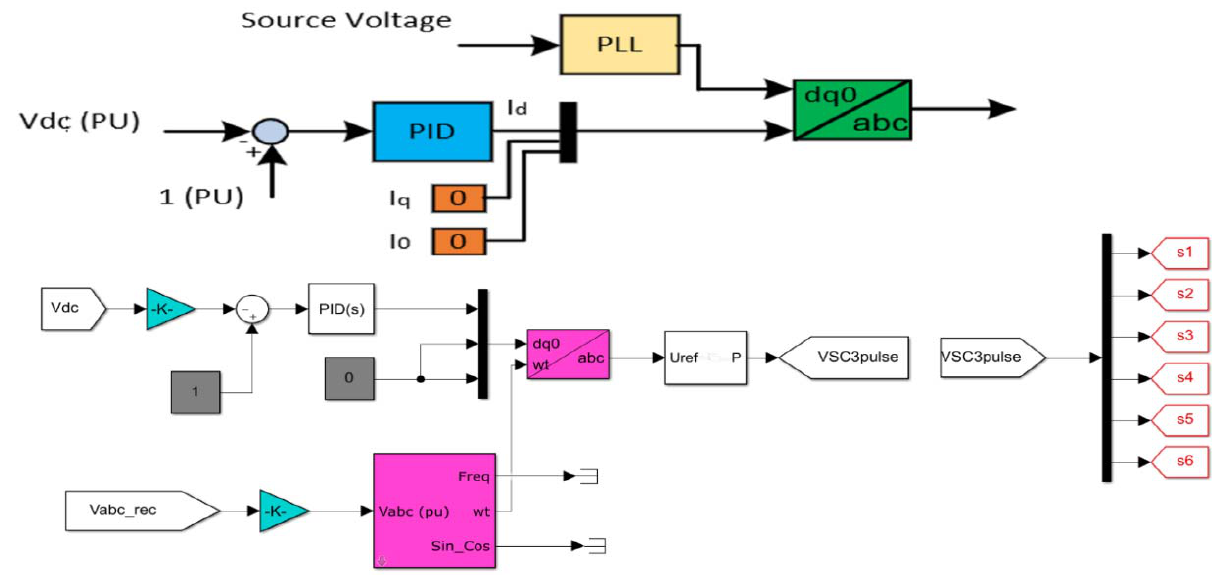
Figure 6. DC voltage rectifier controller simulation.